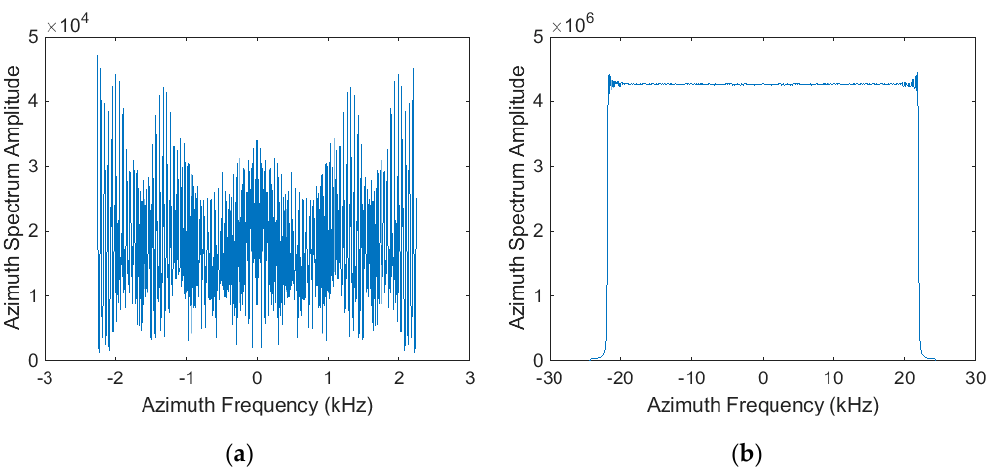
Figure 7. Demonstration of 1D azimuth profile of 2D spectrum. ( a ) 1D azimuth profile of 2D spectrum without application of modified deramping-based approach; ( b ) 1D azimuth profile of 2D spectrum with application of modified deramping-based approach.